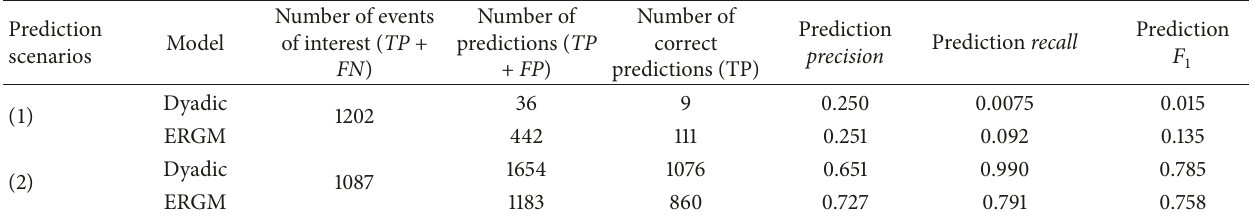
Table 8: The prediction precision and recall at the threshold of 0.5 in two prediction